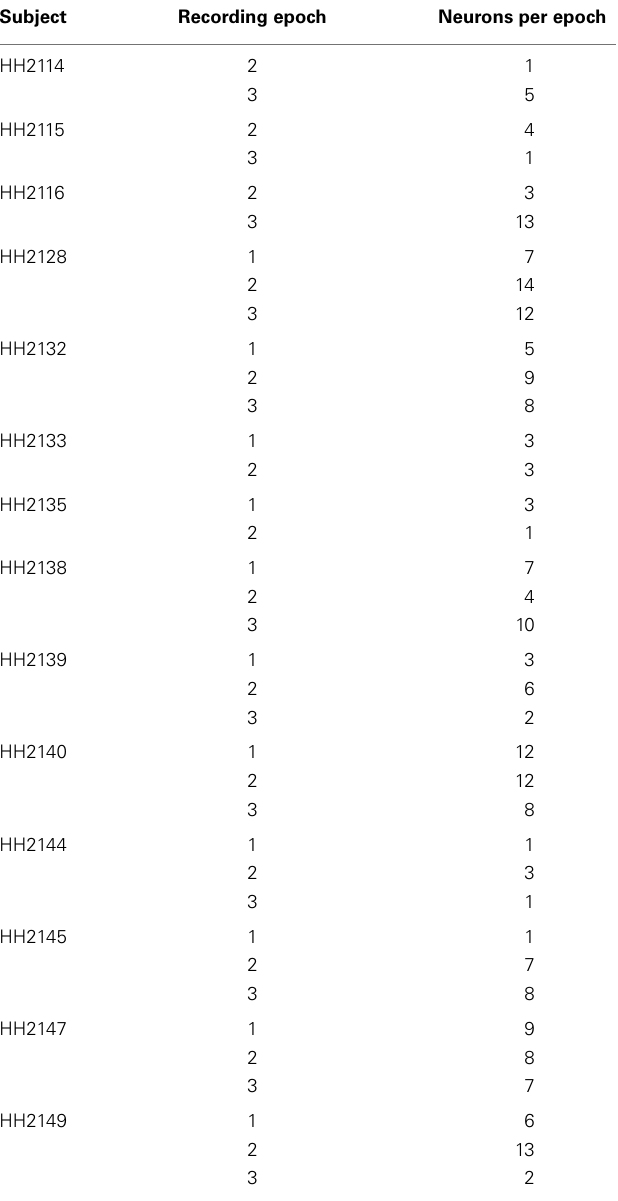
Table 1 | Number of neurons recorded for each